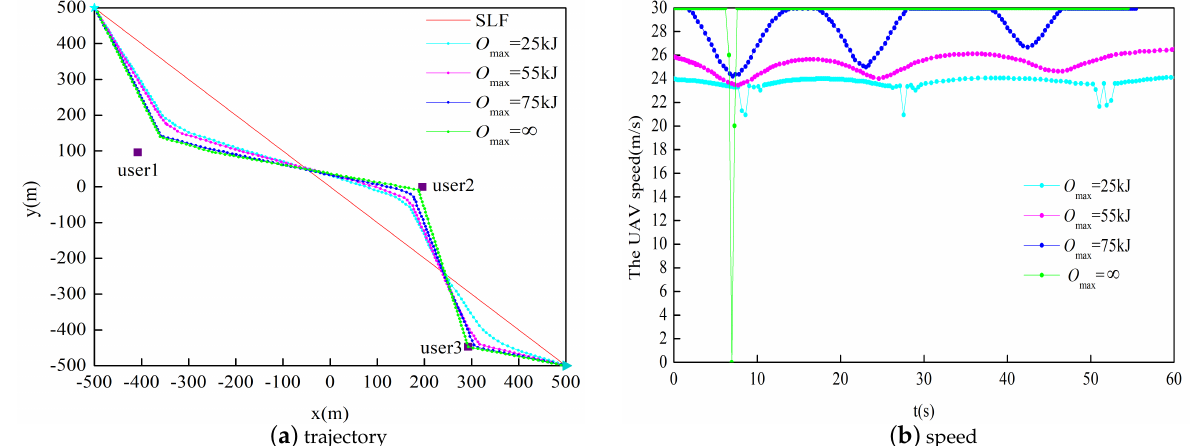
Figure 8. Under different energy constraints, the trajectory and speed of the UAV after adopting the IMP algorithm.